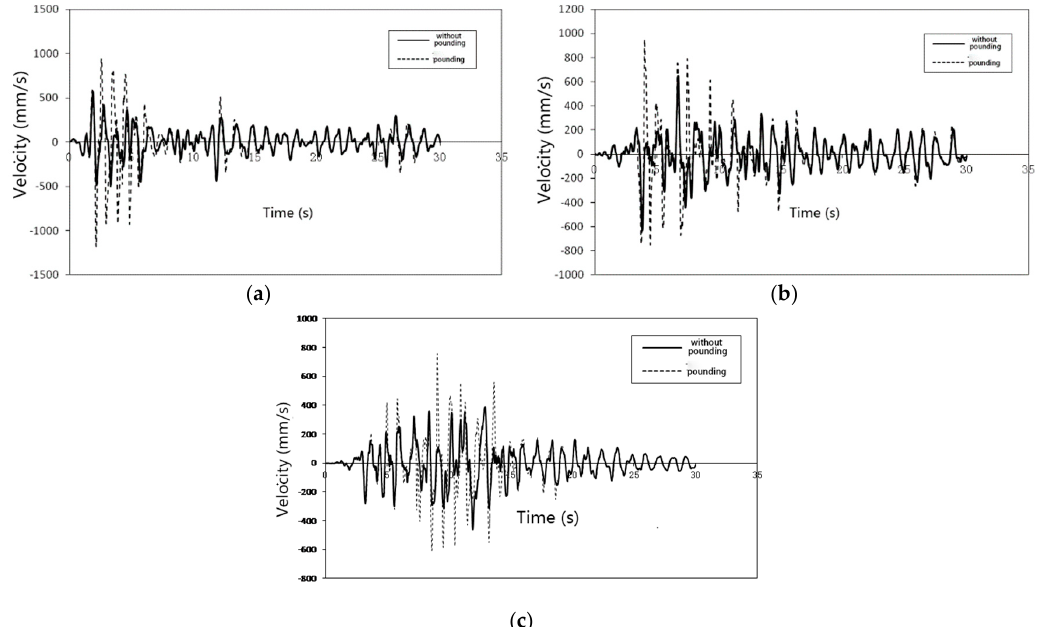
Figure 18. Structural velocity under different earthquakes (model A). ( a ) El Centro earthquakes; ( b ) Taft earthquake; and, ( c ) Artificial excitation.